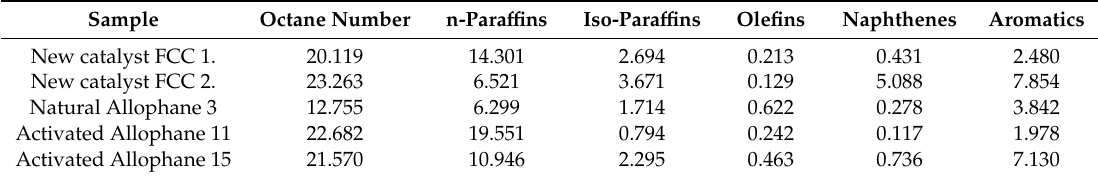
Table 21. Liquid products of catalytic cracking MAT.